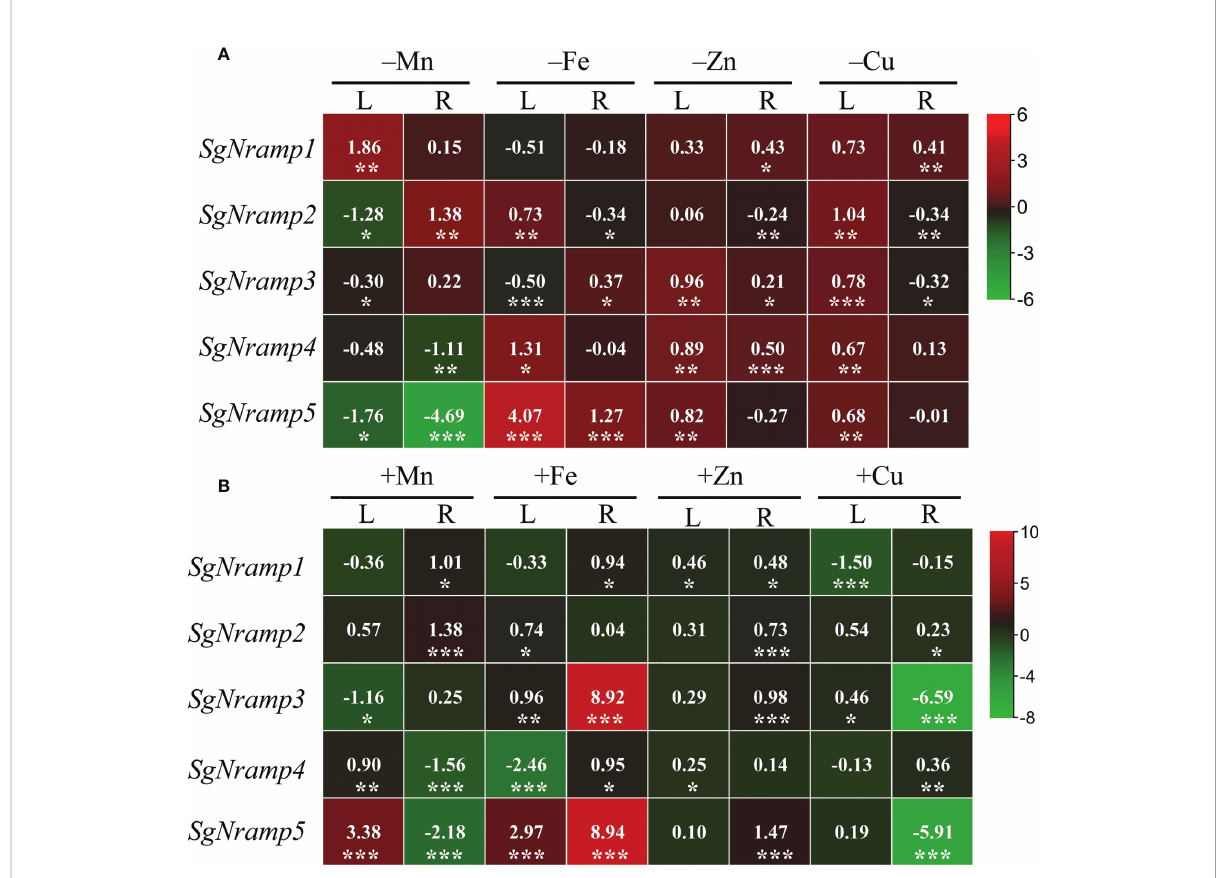
FIGURE 4 Expression analyses of SgNramps in leaf and root of stylo under metal stresses. (A) Expressions of SgNramps in leaf (L) and root (R) of stylo grown in nutrient solution without MnSO 4 ( – Mn), Fe-Na-EDTA ( – Fe), ZnSO 4 ( – Zn), or CuSO 4 ( – Cu) applications for 7 days. (B) Expressions of SgNramps in leaf (L) and root (R) of stylo grown in nutrient solution supplied with 400 m M MnSO 4 (+Mn), 800 m M Fe-Na-EDTA (+Fe), 20 m M ZnSO 4 (+Zn), or 10 m M CuSO 4 (+Cu) for 7 days. Stylo seedlings grown in full-strength Hoagland solution were set as the control treatment. The data include three biological replicates. The values represented the fold change of each SgNramp expression between metal stress and the control (CK), which were calculated as log 2 (metal stress/CK). The positive and negative values represent up- and down-regulation, respectively. Asterisks below the values indicate signi fi cant differences between metal stress and CK. * P < 0.05; **0.001 < P < 0.01; *** P <